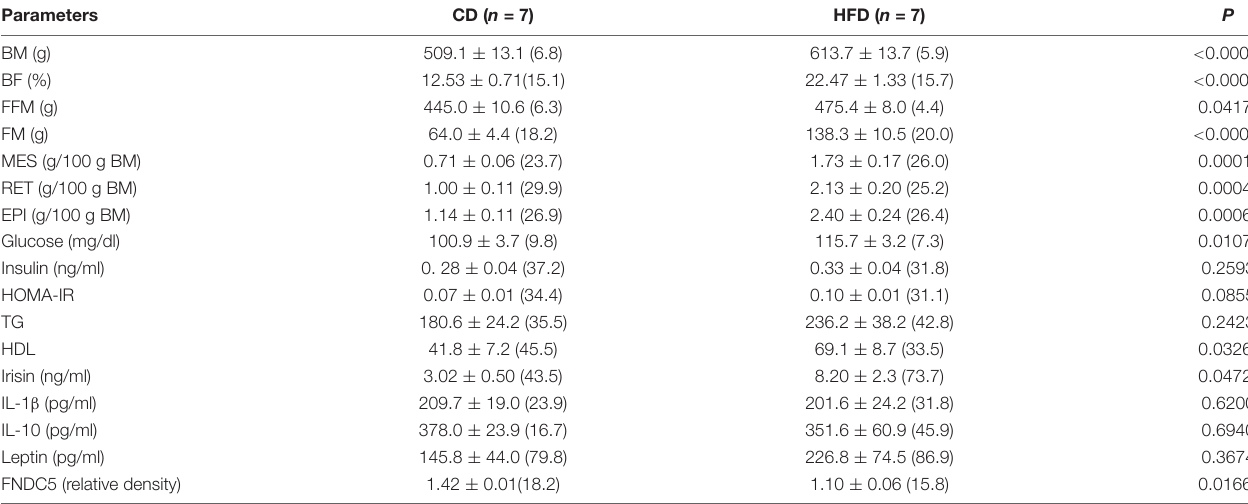
TABLE 2 | Body composition of diet-induced obesity for 8 weeks.